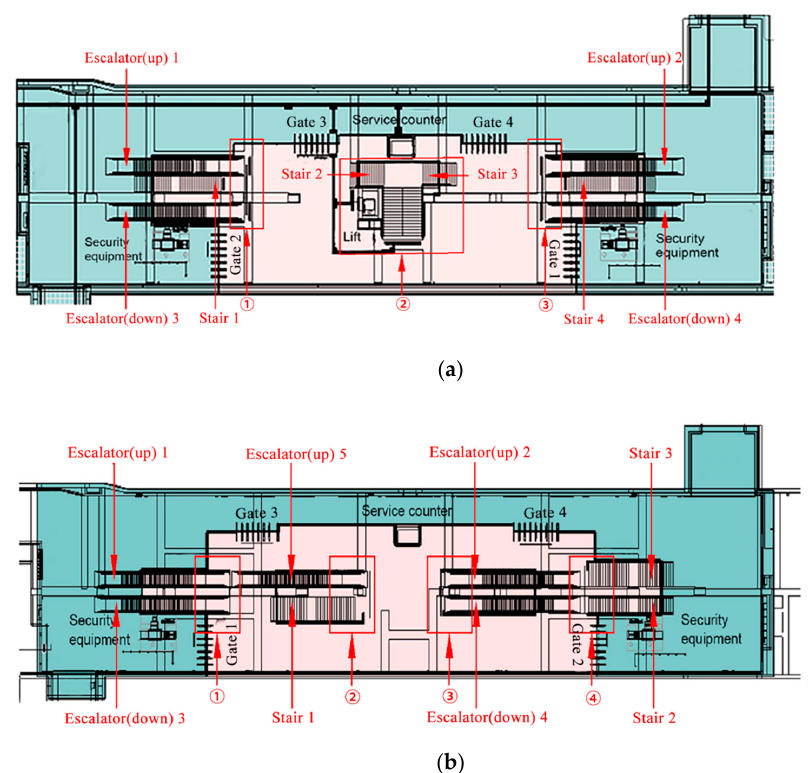
Figure 3. Layout schematic diagrams of station hall floor before and after optimization: ( a ) layout diagram of the hall floor of the original scheme; ( b ) layout diagram of hall floor of optimized station. The three-dimensional visualization model of the subway station established by BIM technology is shown in Figure 4.